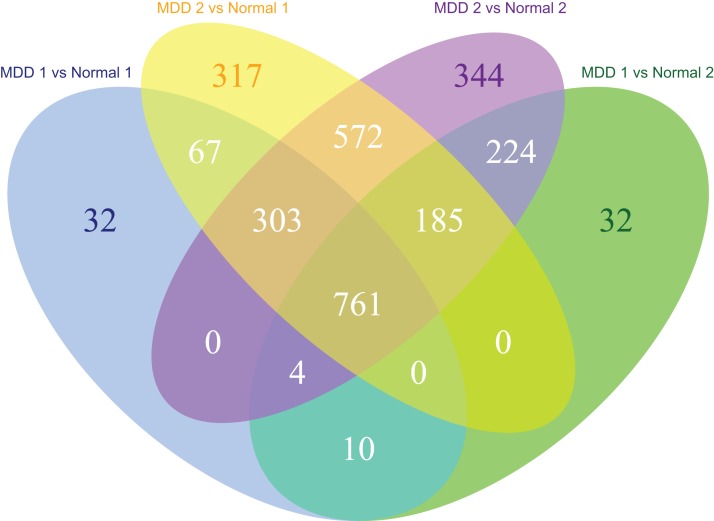
Venn diagram of the differentially expressed genes significantly associated with major depression disorder which were short-listed for the cross-validation.